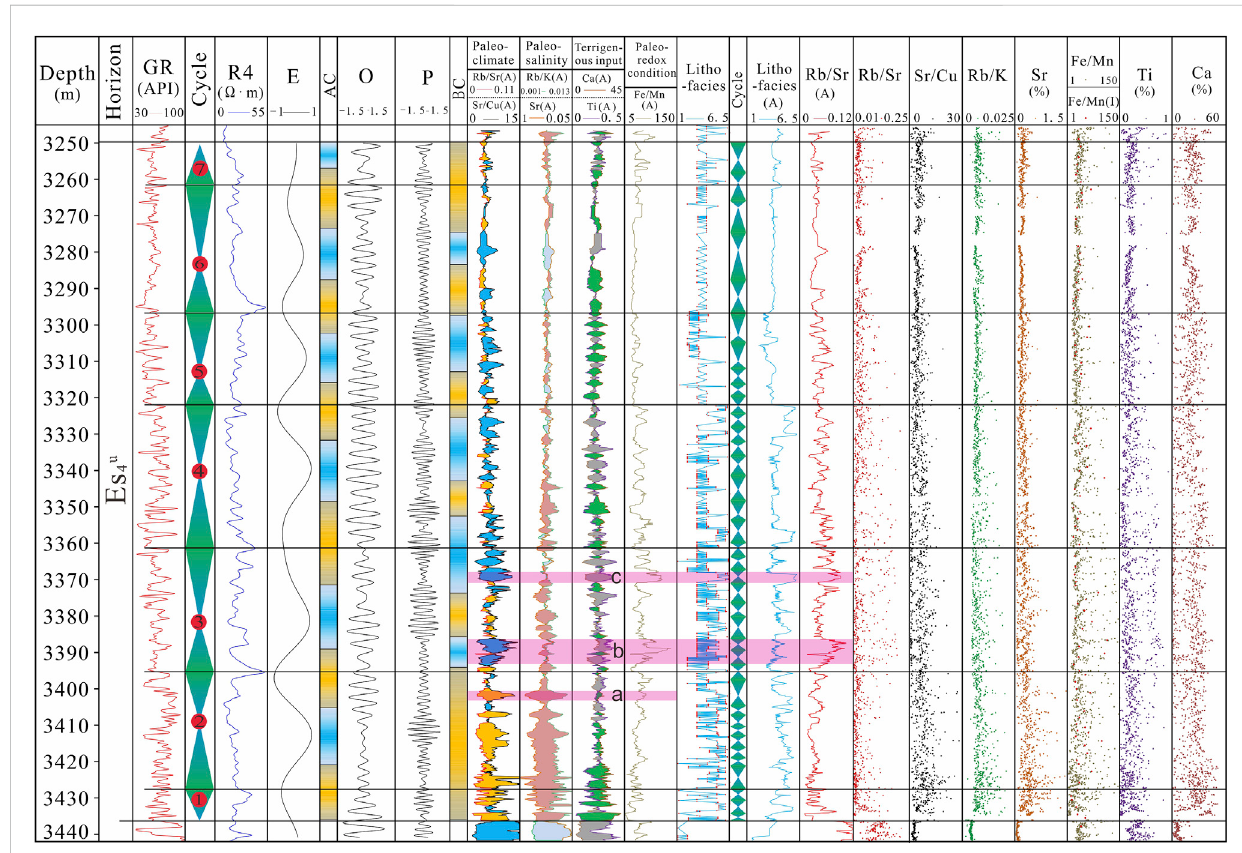
FIGURE 9 Comprehensiveanalysisoflithofaciescycles,astronomicalparameters,andpaleoenvironmentalparameters[(A)meansmovingaverage,period6#].